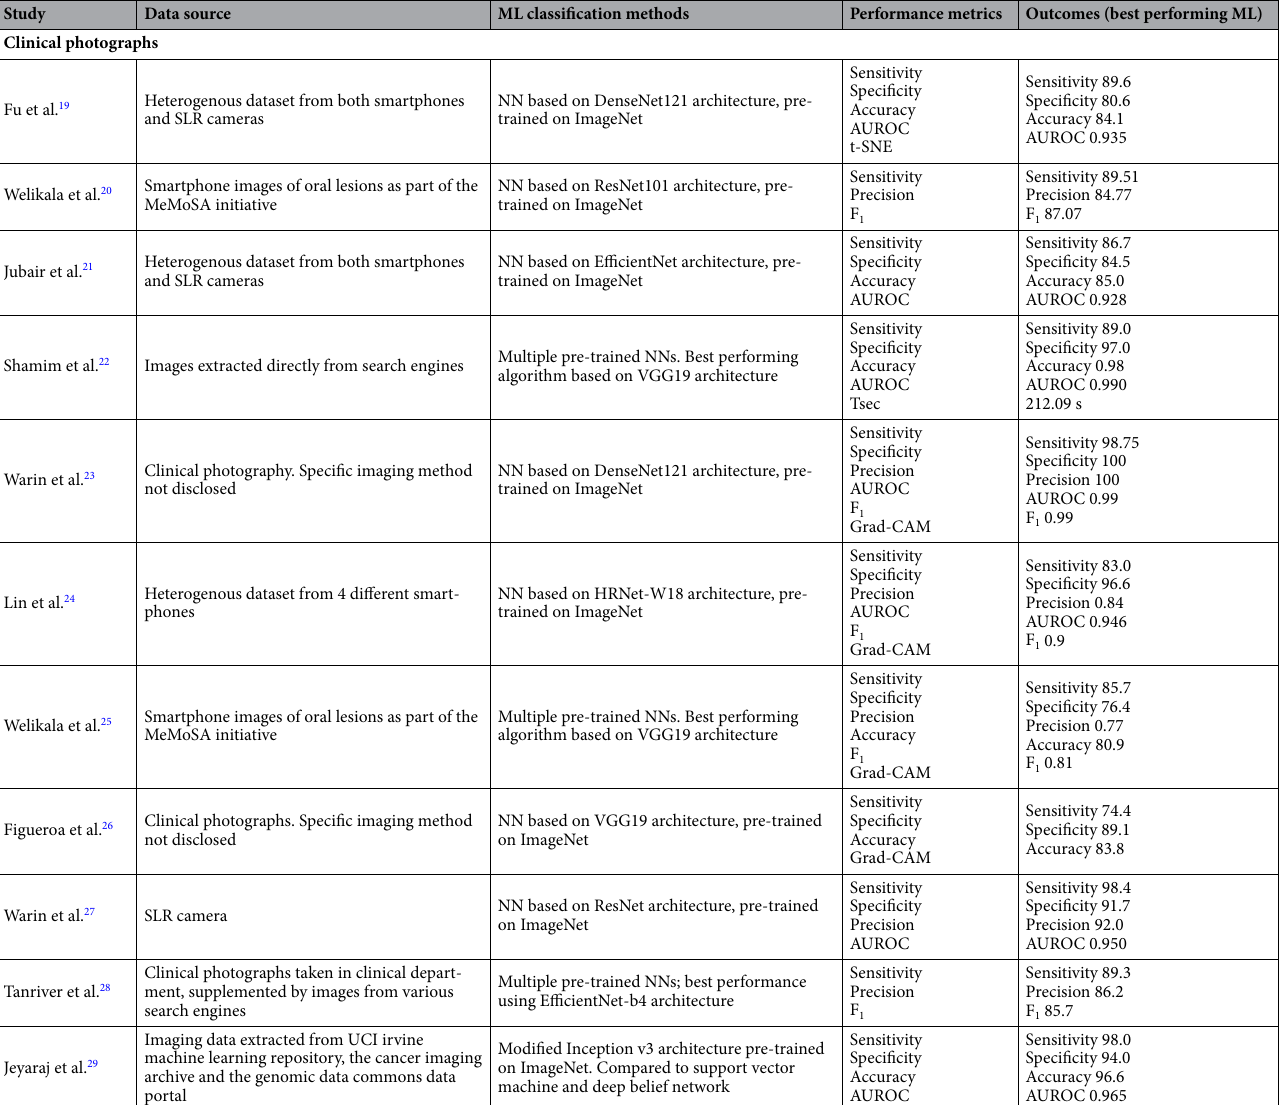
Table 1. Summary of identified studies using clinical photography as the screening